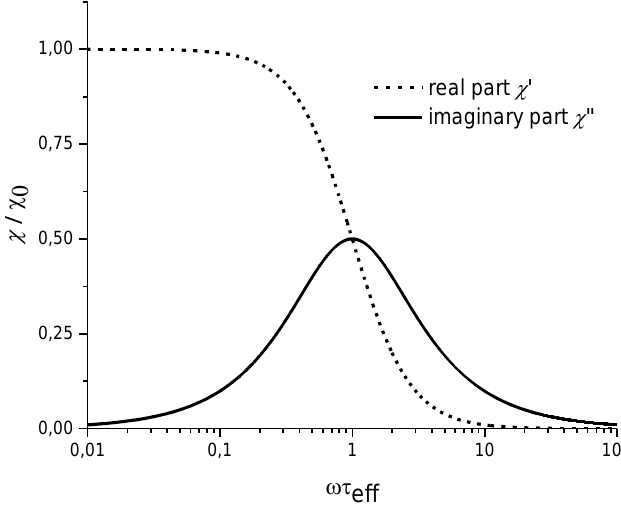
Figure 4. Relative magnetic susceptibility χ / χ 0 in dependence of ωτ eff . The real and the imaginary part of the magnetic susceptibility are plotted against the product of the angular frequency of the magnetic excitation field ω and the effective relaxation time τ eff . The maximum of the imaginary part χ'' occurs at ωτ eff = 1. An effective relaxation time of 50 µs is assumed.